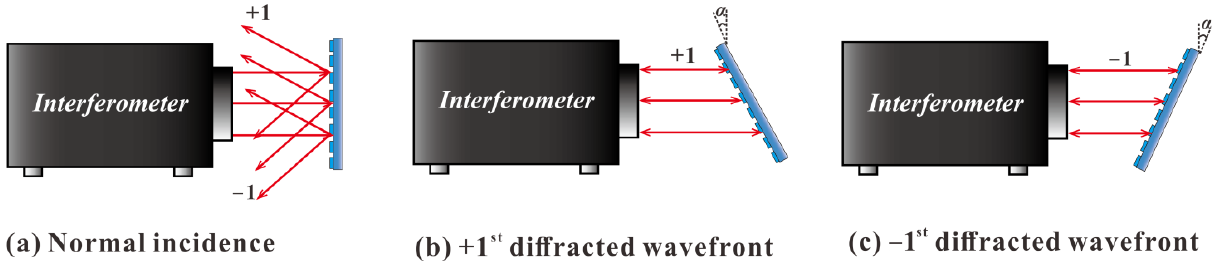
Figure 10. Schematics of the absolute test method for linear gratings. Optical configuration includes ( a ) normal incidence, ( b ) +1st diffracted wavefront and ( c ) − 1 st diffracted wavefront.